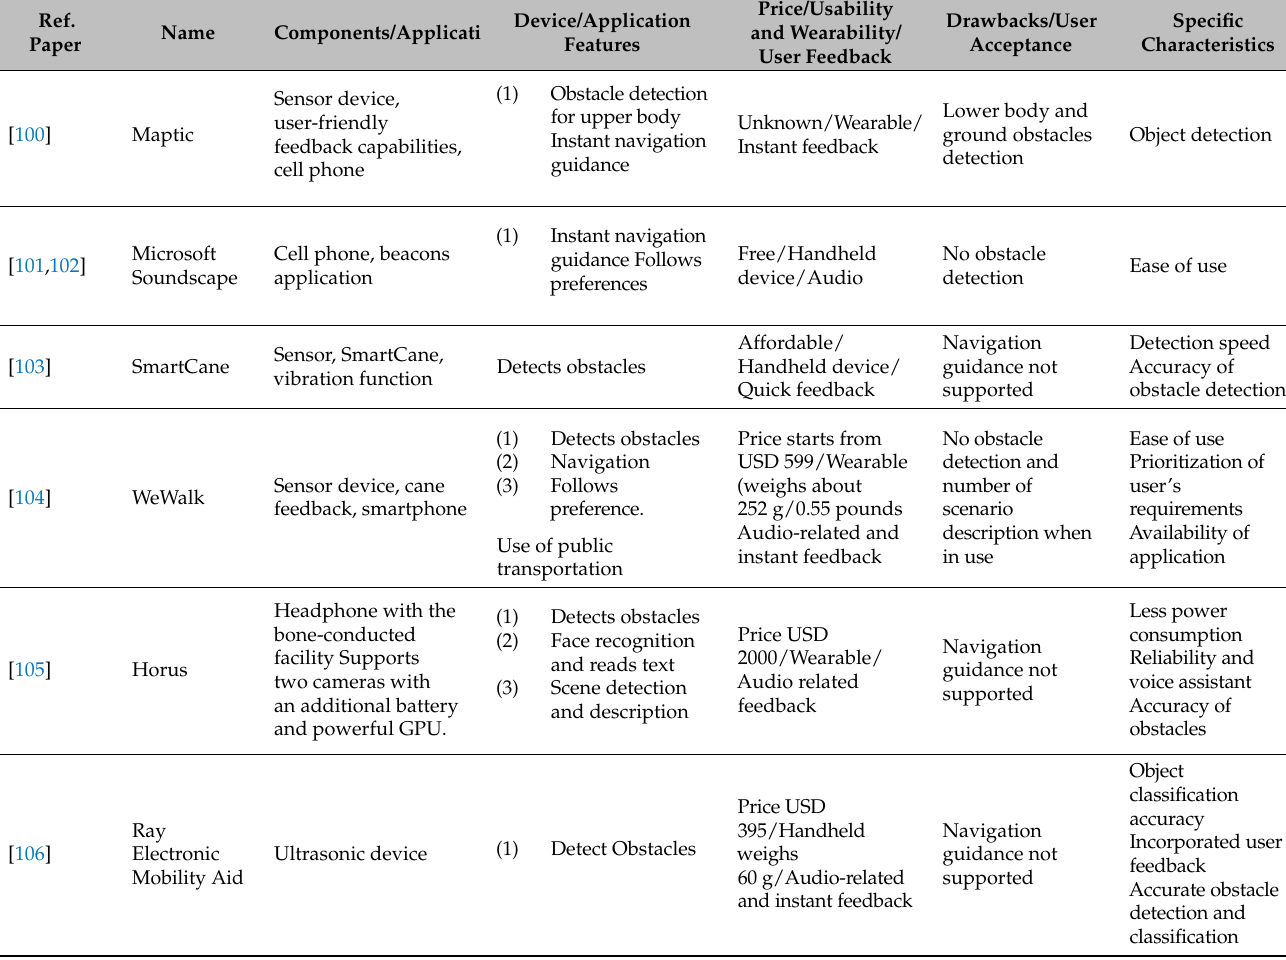
Table 12. Navigation Applications for Visually Impaired